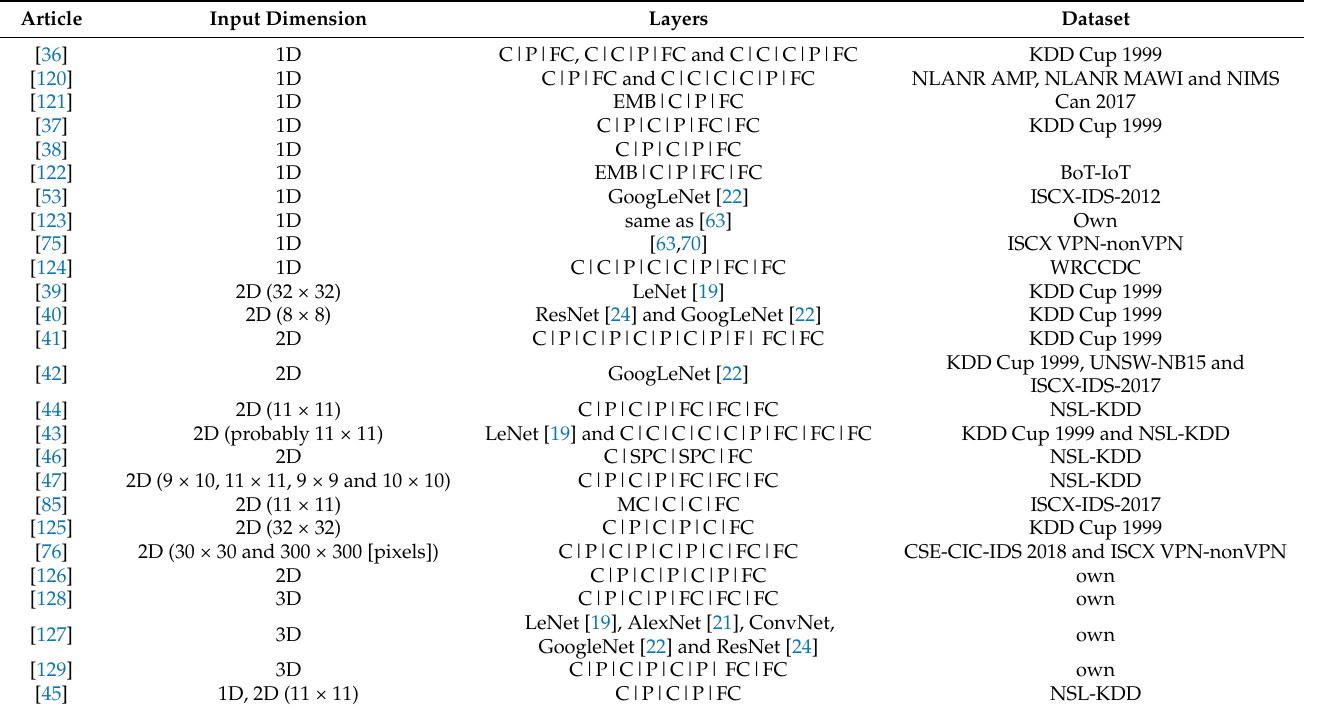
Table 7. The summary of all feature-based